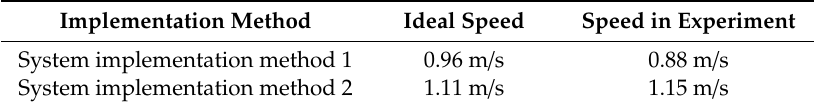
Table 11. The fastest ball speed that the system can block after the actual test.